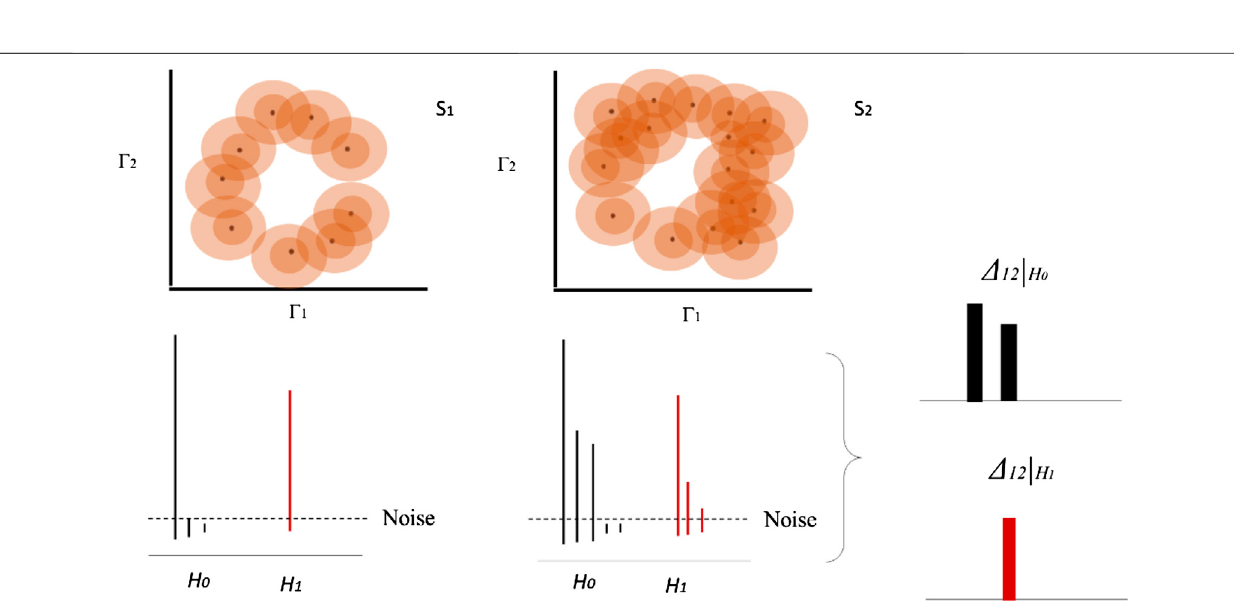
Frontiers in Physics |